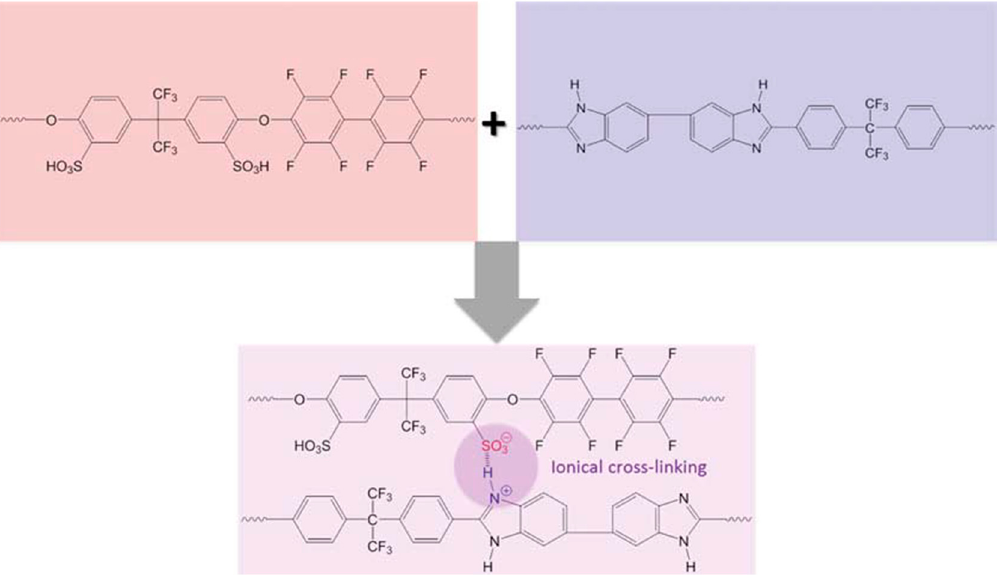
Figure 2. Acid-base polymer cross-linking (from Ref. [34]).